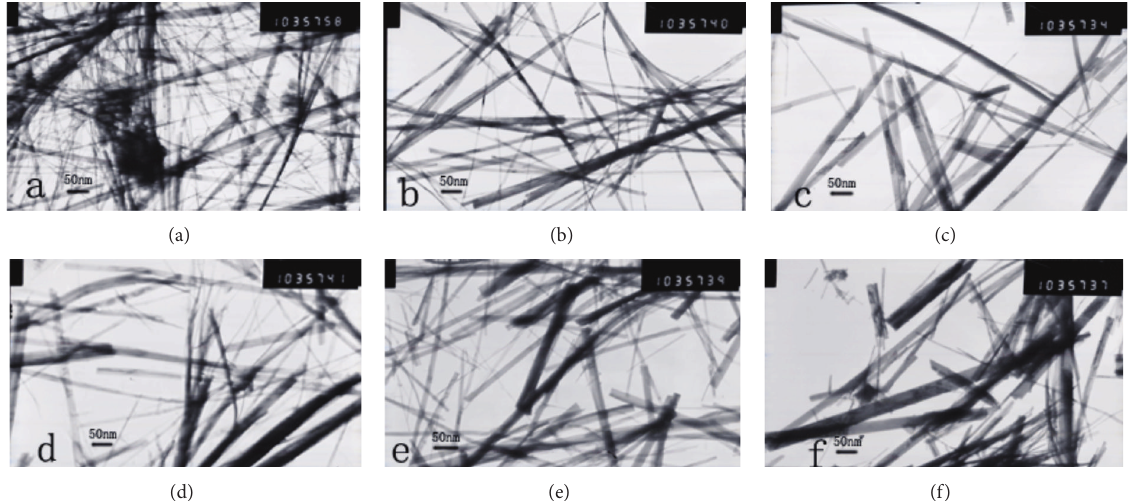
Figure 1: The TEM images of as-synthesized samples: (a) pure TNT, (b) Fe-TNT-0.1, (c) Fe-TNT-0.5, (d) Fe-TNT-1, (e) Fe-TNT-3, and (f) Fe-TNT-5.